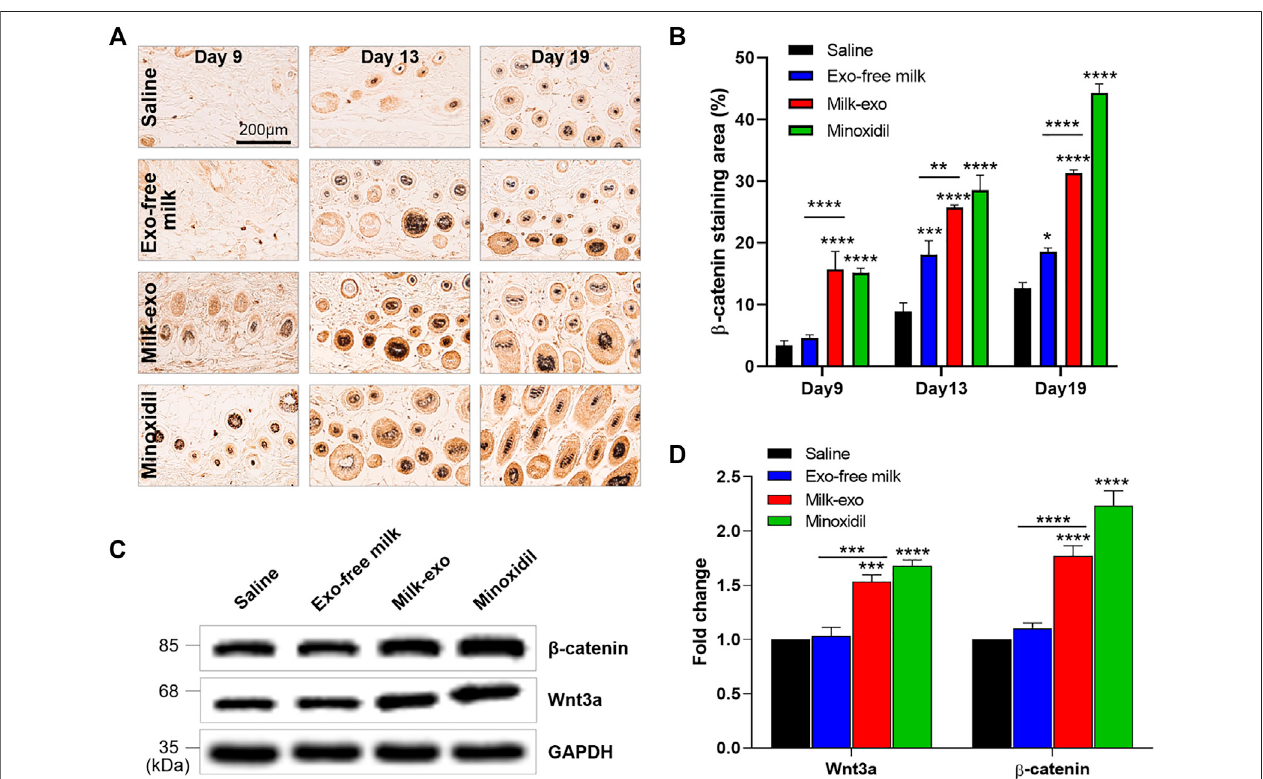
FIGURE 7 | Milk-exo activates Wnt signaling for the transition to the growth phase. (A) Immunohistochemical analysis ofthe expression of β -catenin in hair follicles section (day 9, day 13 and day 19). (B) Quanti fi cation of relative expression of β -catenin from fi ve tissue samples ( n = 4). Data are presented as mean ± SEM (* p < 0.05, ** p < 0.01, *** p < 0.001 and **** p < 0.0001). (C) Western blot analyzing β -catenin, Wnt3a and GAPDH protein content in the dorsal skin on day 9. (D) Quanti fi cation of western blot protein levels by group. Data are presented as mean ± SEM (n = 3; *** p < 0.001 and **** p <